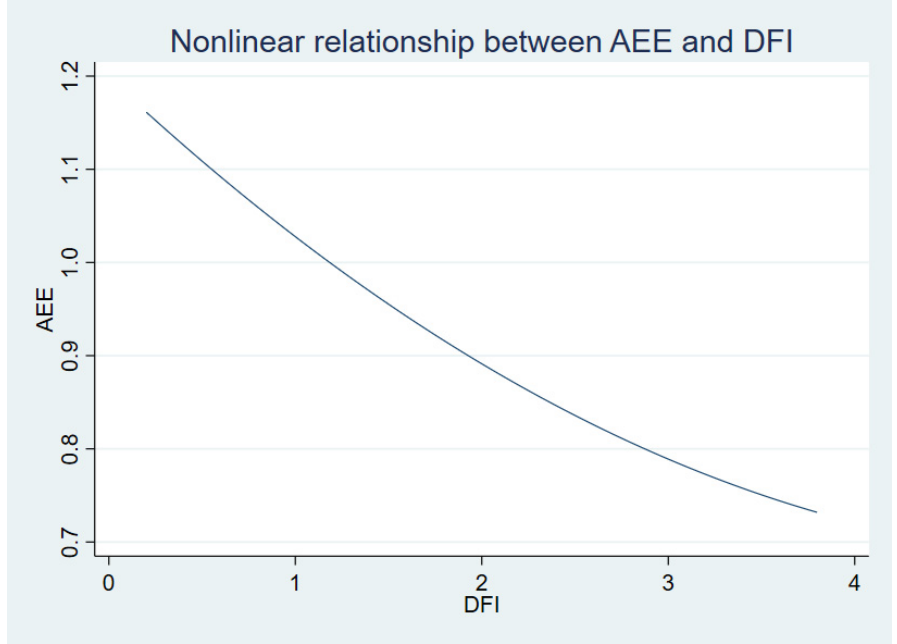
Figure 2. “U”-shaped curve of empirical regression